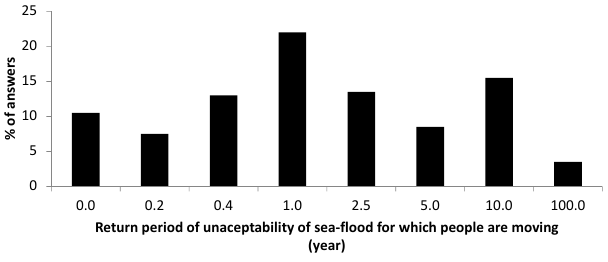
Fig. 4. Threshold of acceptability to sea flooding, based on the an- swers of residents and shopkeepers of DEMO city to the question: Above which frequency of sea-flooding inundation of your house, would you leave your home? The results exclude the 5.5% who did not answer. Data provided by the MISEEVA project (Vinchon et al., 2010).